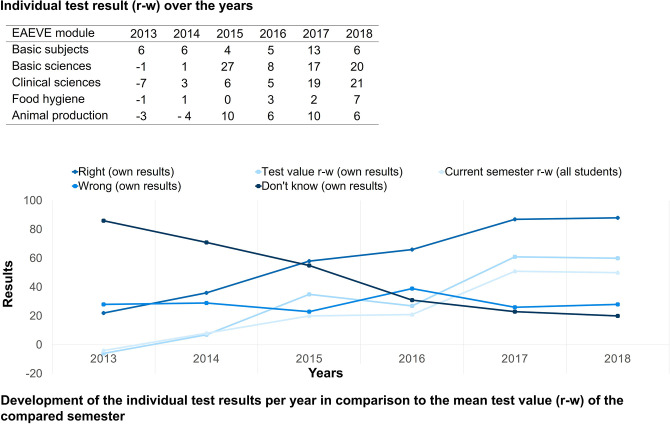
Individual test result over the years (for the students also available as graphics) and progress display of individual results and compared semester, exemplary presentation of an eleventh-semester student; r, right answer; w, wrong answer.